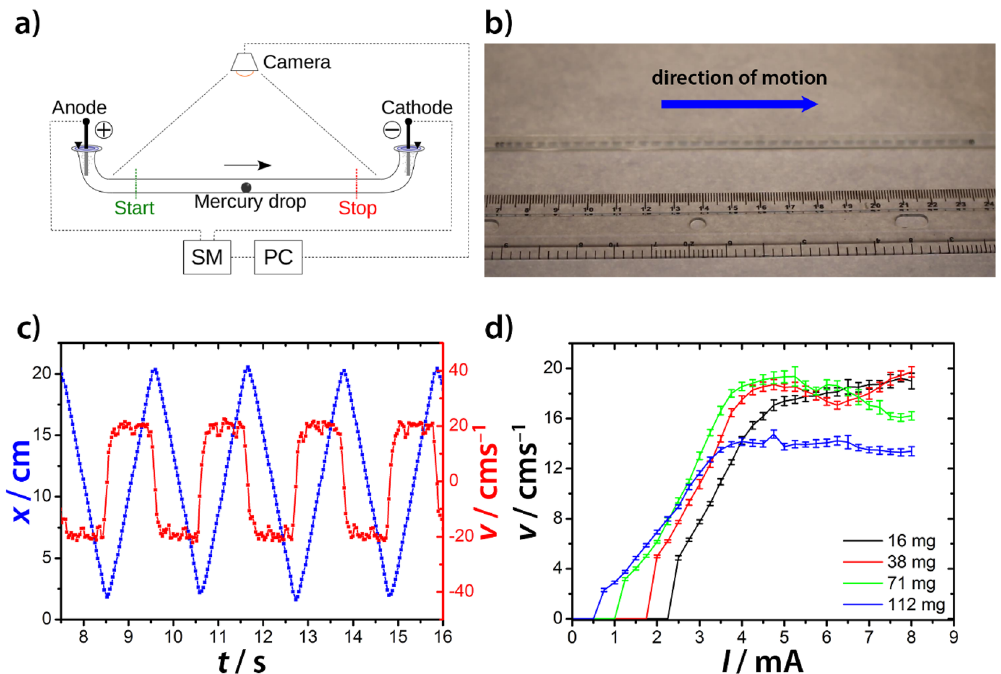
Figure 1. ( a ) The sketch of the experimental setup to investigate the motion of a Hg droplet in a direct electric field. ( b ) The motion of a Hg droplet ( m = 38 mg) in a direct electric field using the galvanostatic condition ( I = 3.0 mA) and a capillary tube (diameter of 3.3 mm) filled with the solution of sulfuric acid ( c = 25.0 mM). The superimposed image shows the position of the droplet every 0.04 s. ( c ) The position-time graph of the Hg droplet (blue) and the velocity of the droplet (red). The droplet exhibits uniform motion. The direction of the electric field was changed whenever the droplet arrived near the cathode. ( d ) Velocity dependence of the Hg droplet for various sizes (masses) on the applied direct electric current in the solution of the sulfuric acid ( c = 25.0